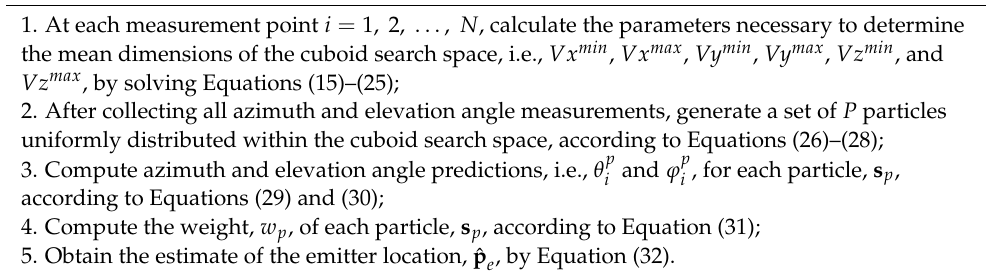
Algorithm 1. PF algorithm for 3D emitter location using azimuth and elevation